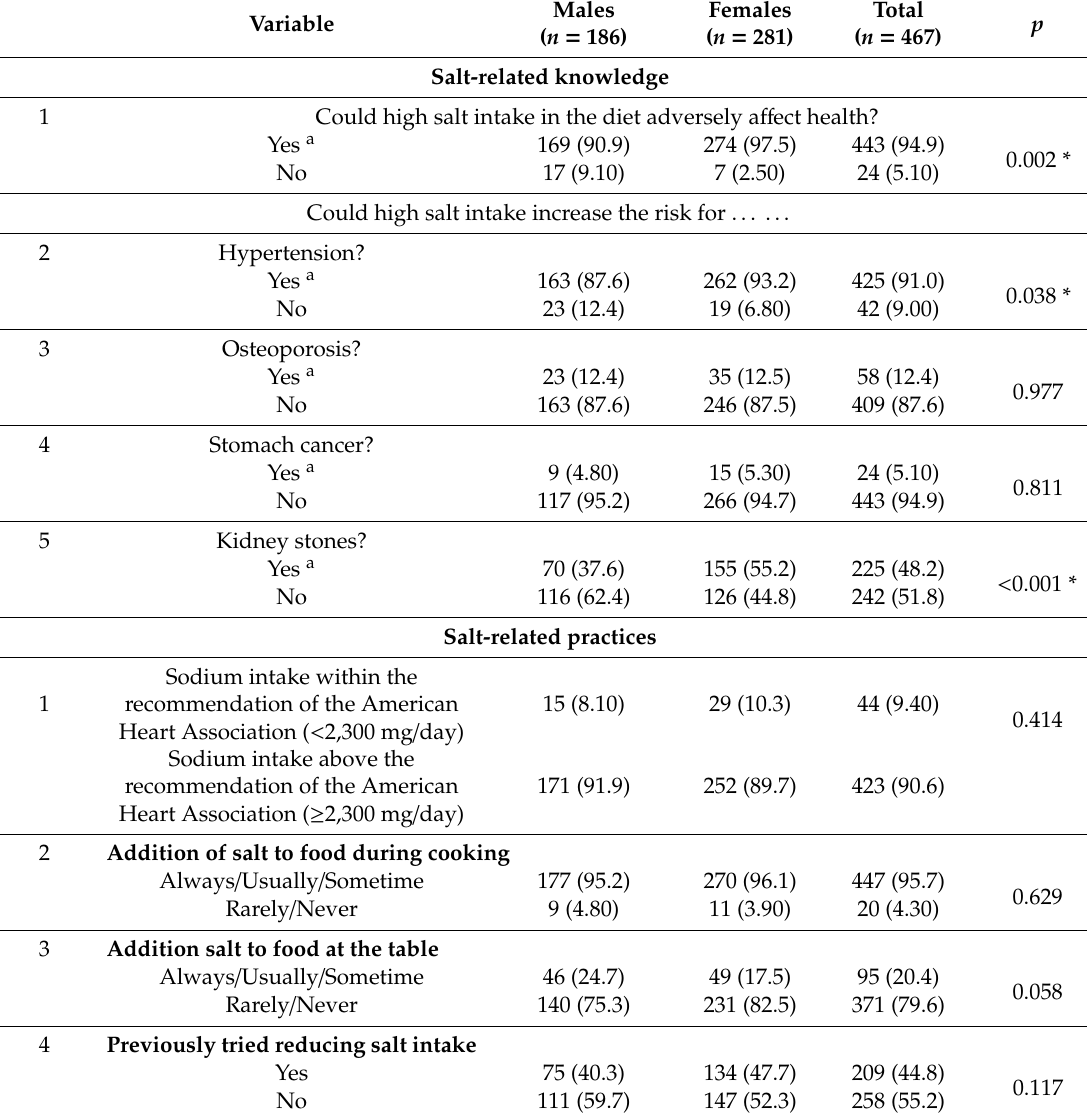
Table 2. Salt-related knowledge and practices stratified by sex (n =